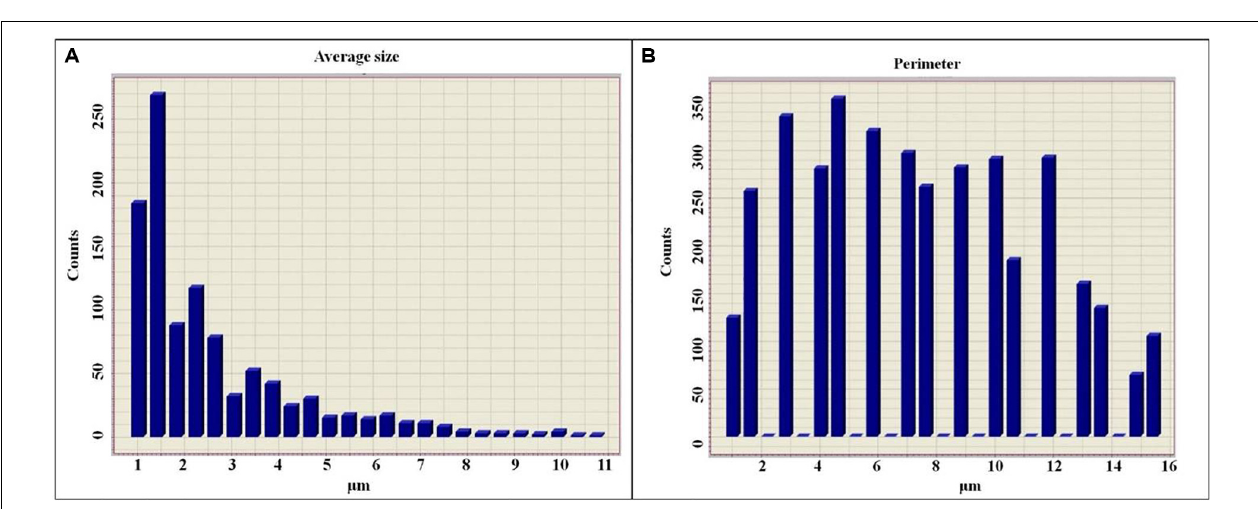
FIGURE 6 | Histogram of the sizes of colloidal particles of diluted solutions of exopolysaccharides (A) , histogram of the perimeters of colloidal particles of diluted solutions of exopolysaccharides (B)